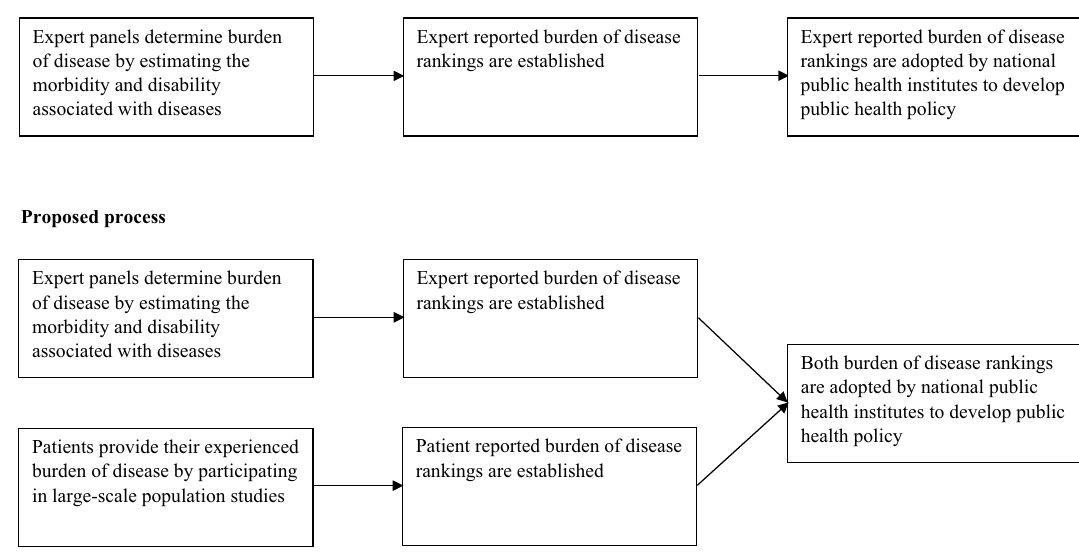
Figure 2. The current and proposed integration of burden of disease rankings in the development of public health